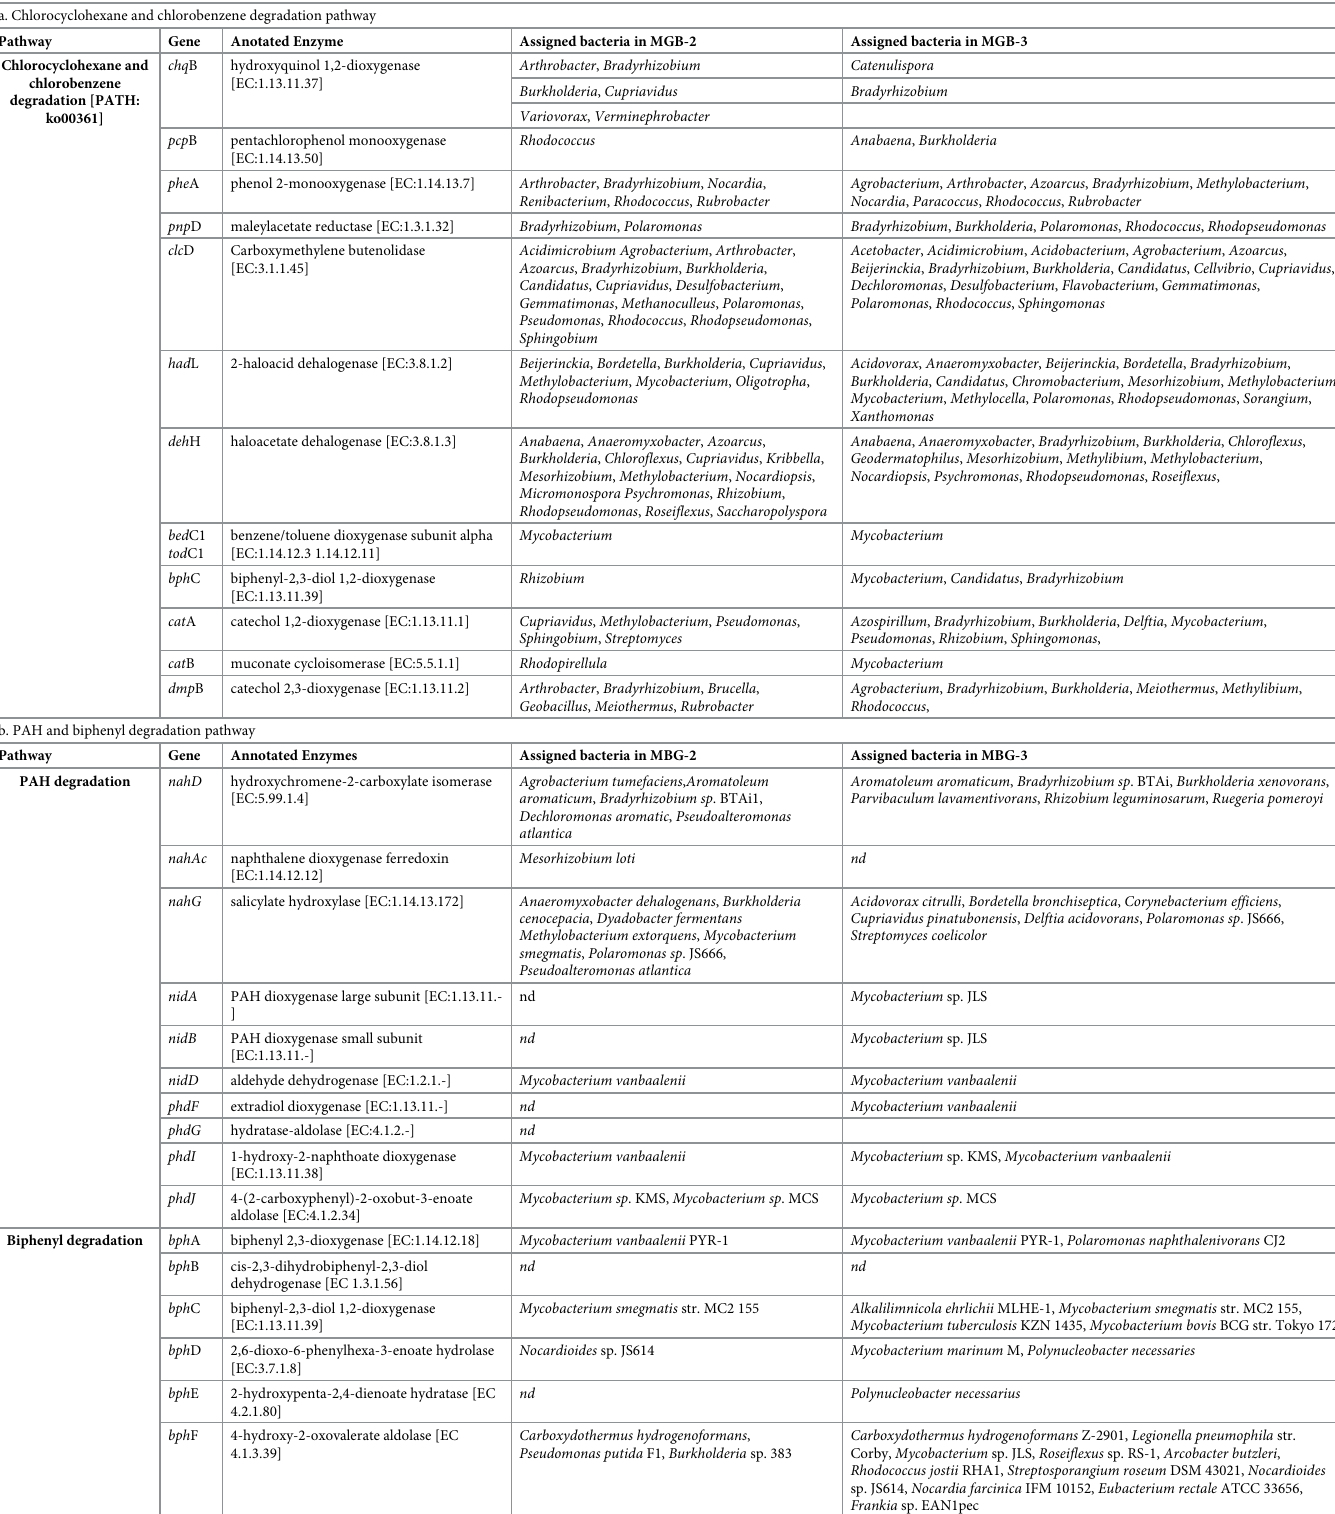
Table 4. Annotated enzyme and the assigned genera in metagenome MGB-2 and MGB-3. a.Chlorocyclohexaneandchlorobenzenedegradationpathway